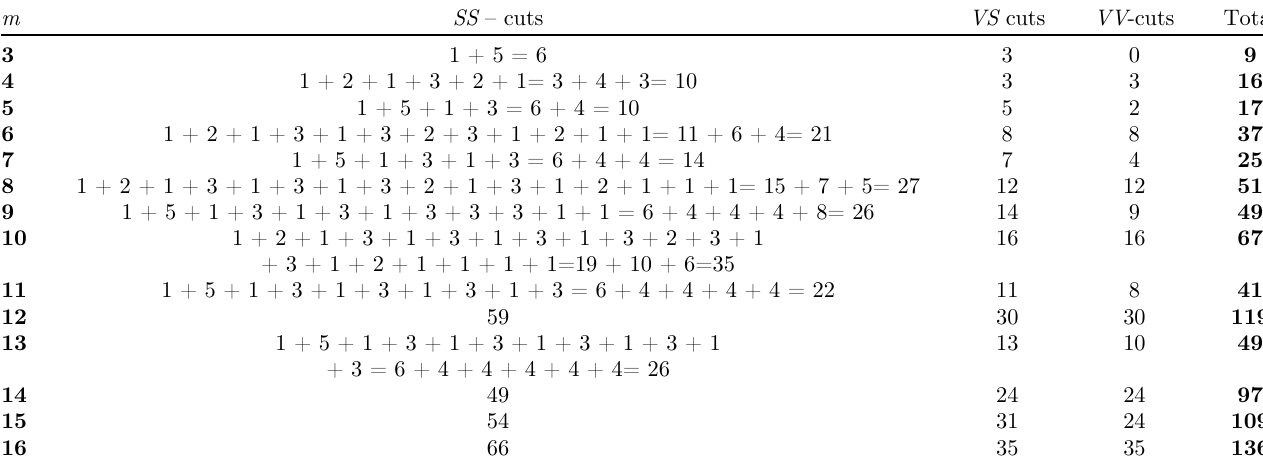
Table 13. All possible cuttings for m-regular polygons for m = 3, 4, ... , 16. m